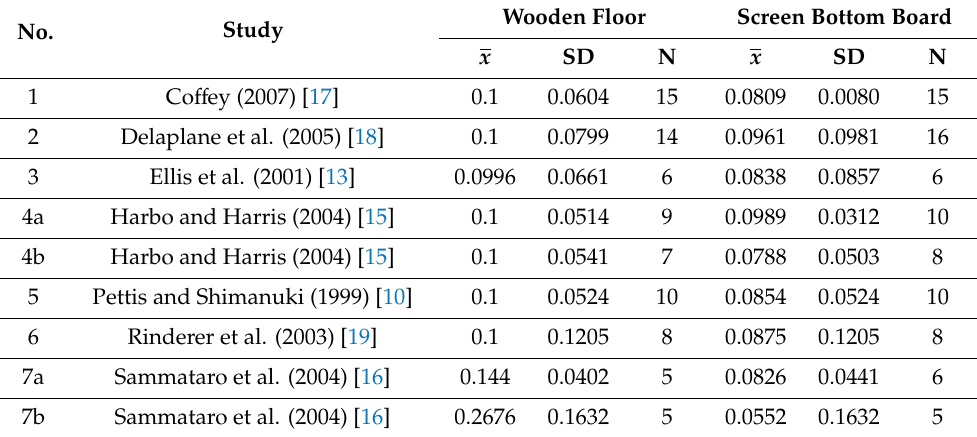
Table 1. Mite density of colonies settled with wooden floor and screen bottom board from seven